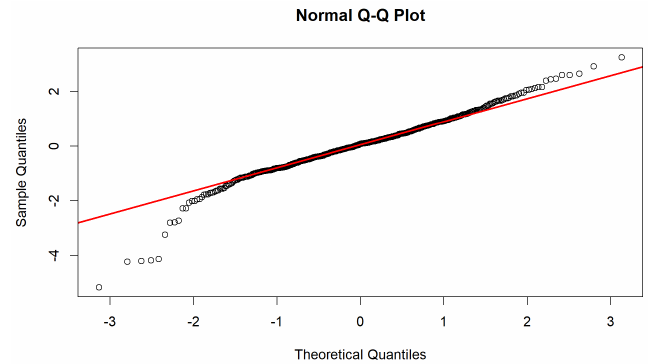
Figure 13. TGARCH Residual Distribution Q − Q Plot.